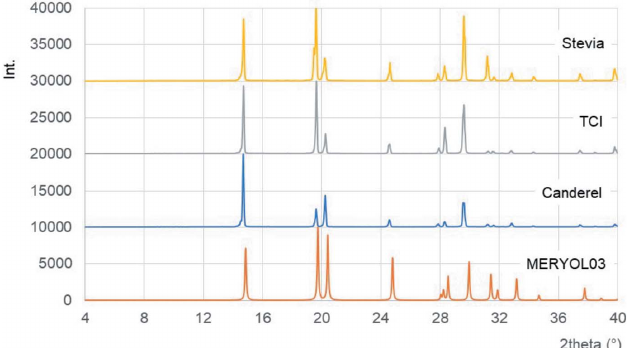
Figure 3 Comparison of the powder diffractograms [intensities (Int.) as a function of the diffraction angle 2 (cid:3) ] for erythritol from different sources. The reference diffractogram was simulated using Mercury (Macrae et al. , 2020) based on the crystallographic structure of MERYOL03 (Ceccarelli et al. ,